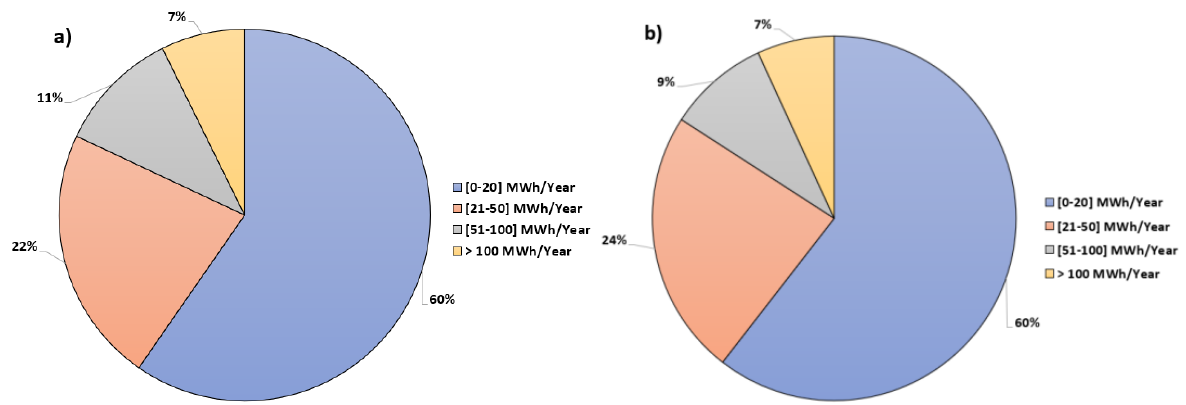
Figure 6. Members ’ annual generation and demand percentage — ( a ) annual generation ( b ) mem- bers ’ annual consumption values.